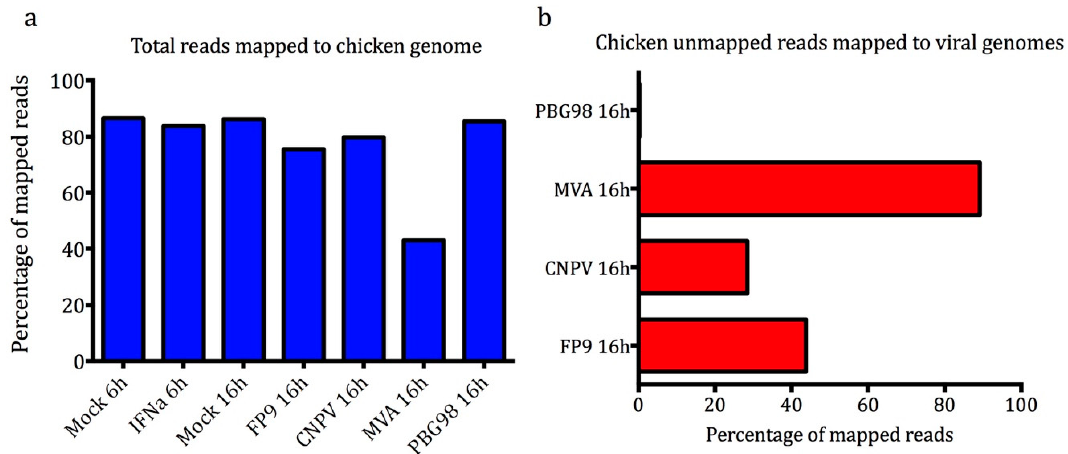
Figure 2. ( a ) Percentages of total reads mapped to chicken reference genome galGal4.82. ( b ) Percentages of the remaining (chicken-unmapped) reads mapping to viral reference